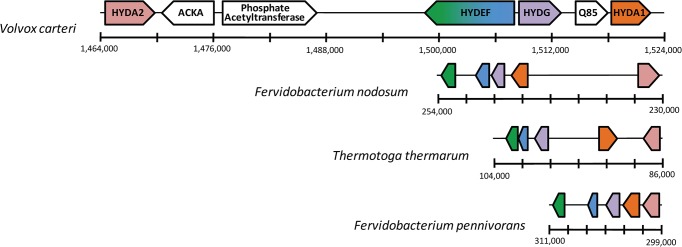
[FeFe]-hydrogenase gene clusters observed in V. carteri, F. nodosum, F. pennivorans, and T. thermarum.Clusters are all on the same scale, and the putative HYD genes are denoted by color (HYDA sequences, orange and pink; HYDE, green; HYDF, blue; HYDG, purple; HYDEF fusion gene, green-to-blue). The gene orientation corresponds to the orientation of each shape. The coding sequence of the F. nodosum and T. thermarum clusters has been reversed (reading 3’ to 5’) to more closely match the orientation of the V. carteri cluster.